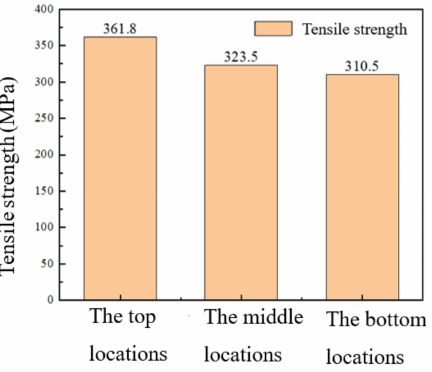
Figure 13. Tensile strengths for different locations of deposited